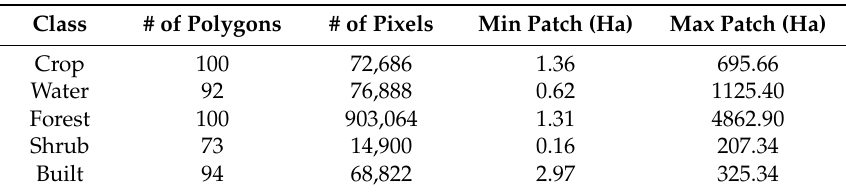
Table 2. Characteristics of training data used for the Classification And Regression Tree to generate a broad class map.